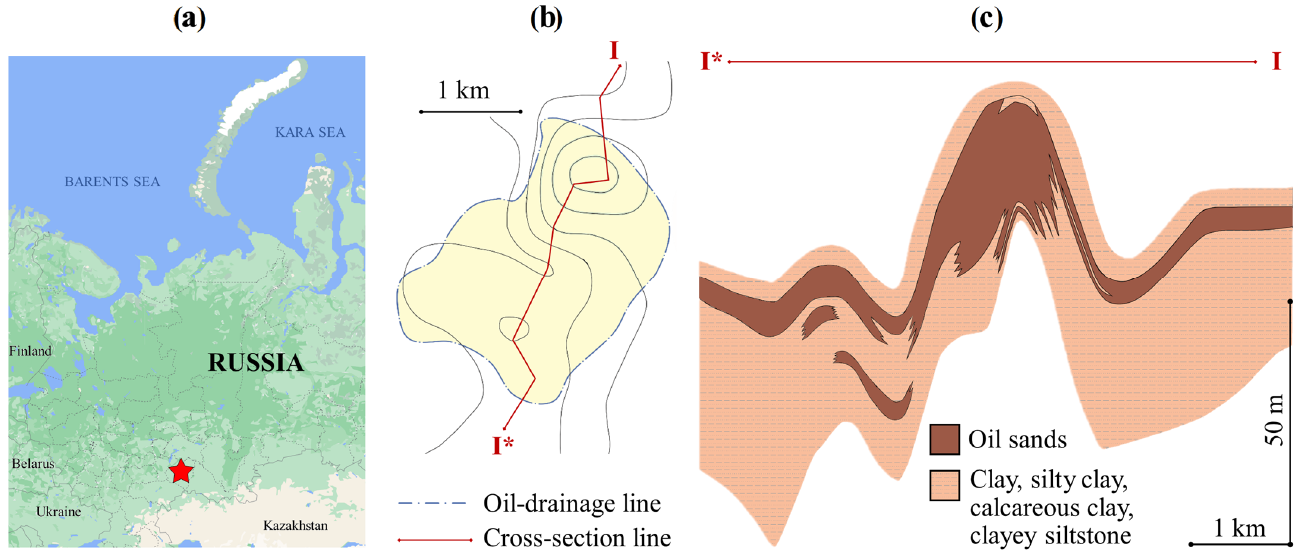
Figure 2. ( a ) Location of Karabikulovskoye field; ( b ) structural map of the top of the permeable part of Ufa stage; and ( c ) schematic geological–lithological cross-section of productive formation along the line I*–I.